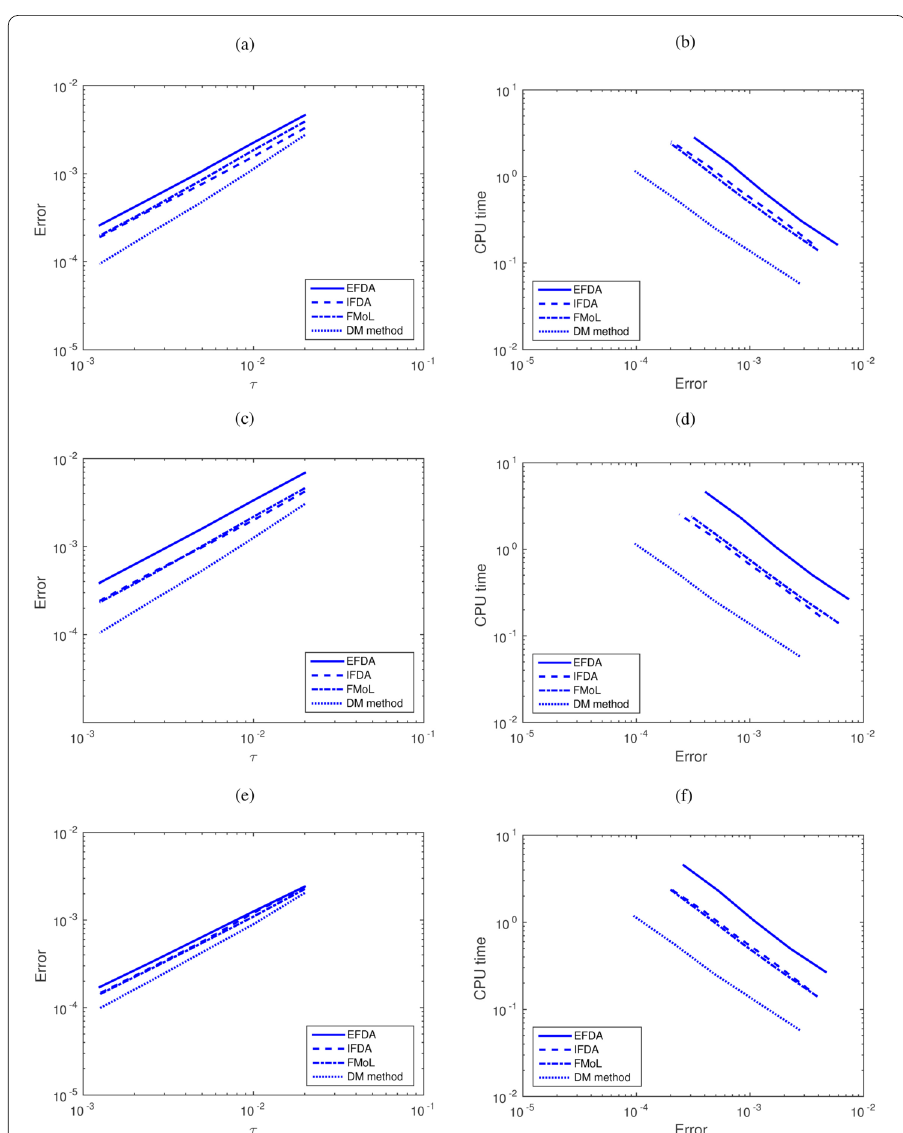
Figure 3 Log–log plots of convergence (left column) and numerical efficiency (right column) of the EFDA (solid), IFDA (dashed), FMoL (dashed–dotted) and DM method (dotted), using various values of α , namely, α = 1.2 (top row), α = 1.4 (middle row), and α = 1.8 (bottom row). The analysis considers problem (1) with reaction function (61), for which the exact solution is given by (62) with K = 0.1. For the simulations, we used Ω = 1 and T =